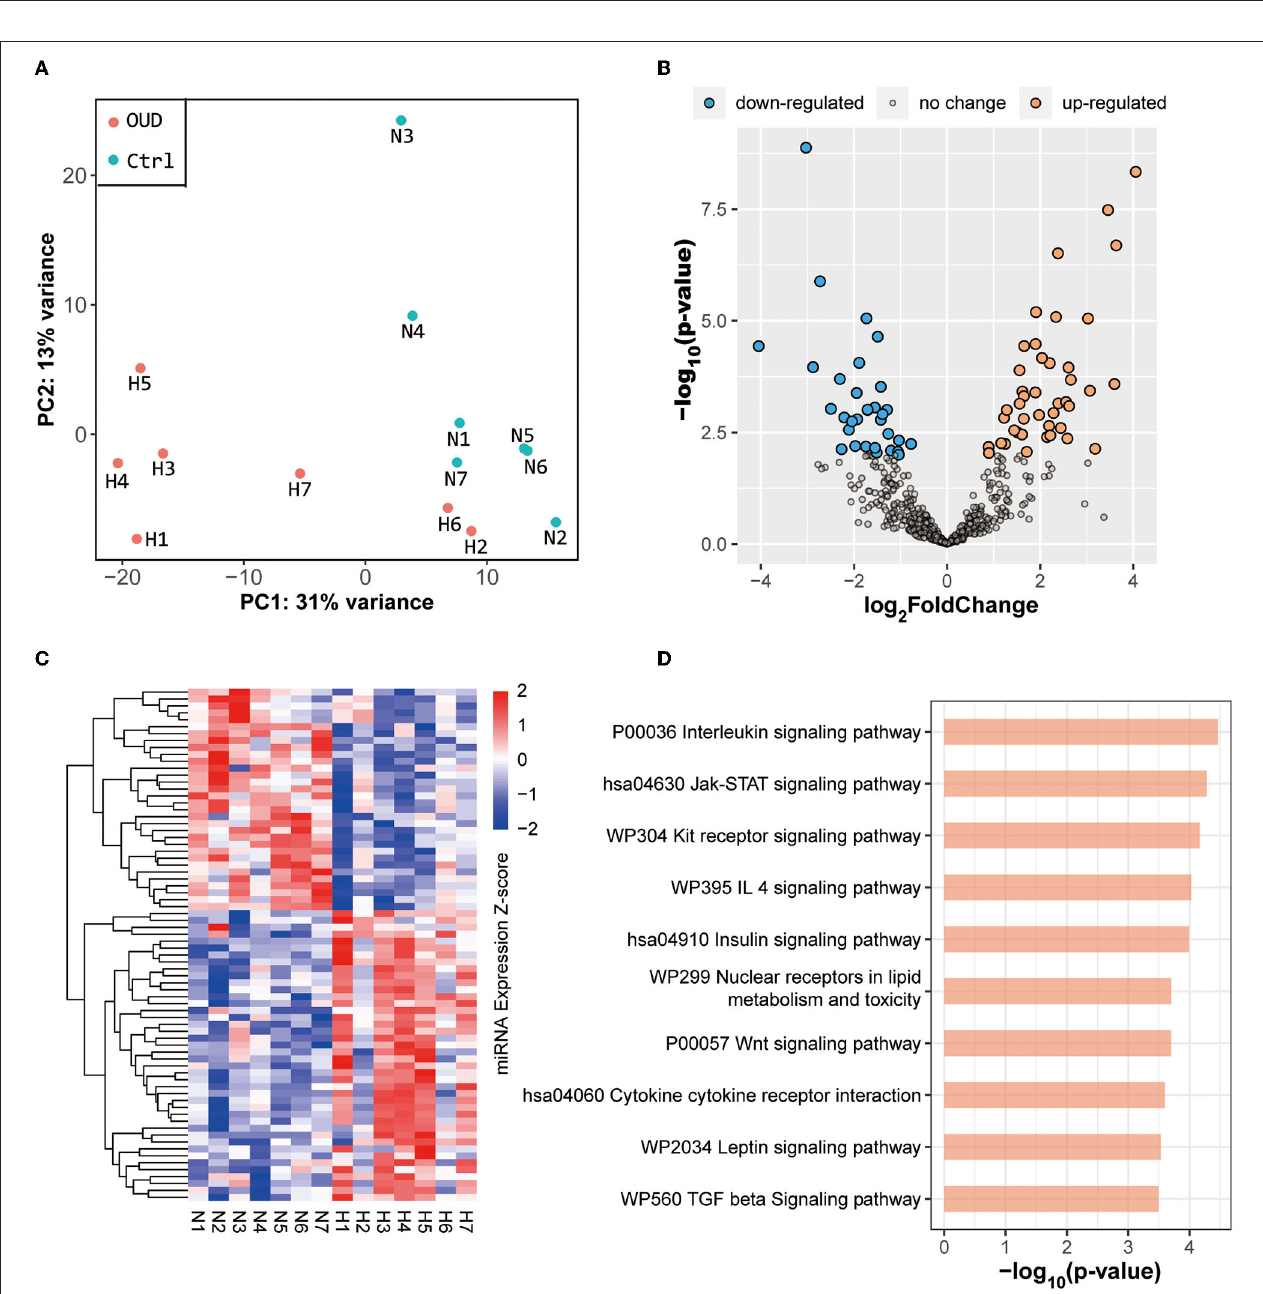
FIGURE 1 | respectively. (C) Expression heatmap of all differentially expressed RNAs, including mRNA, lncRNAs and circRNAs. (D) GO biological process enrichment analysis results with differentially expressed mRNAs. (E) Protein-protein interaction results of differentially expressed genes. Gene names rendered in different colors